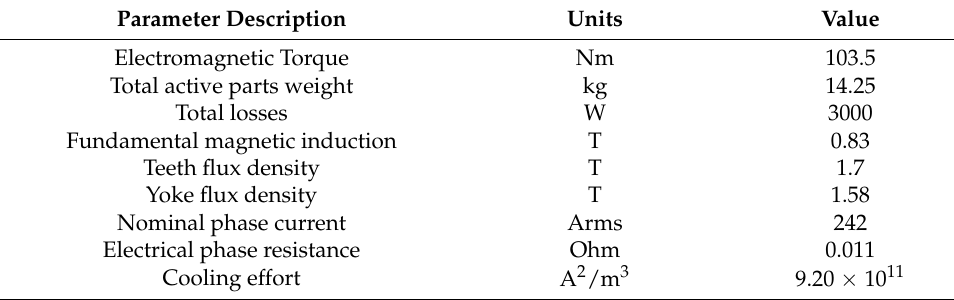
Table 11. Performance of the machine for the optimal design